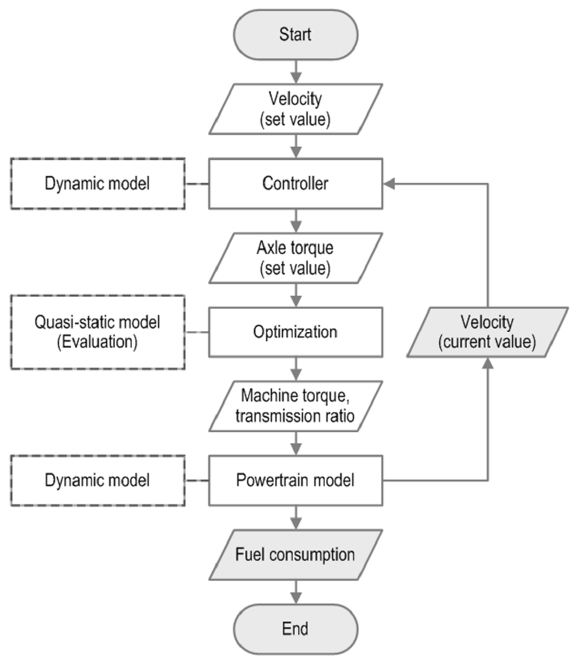
Figure 5. Structure of the simulation models, represented as a simplified program plan.